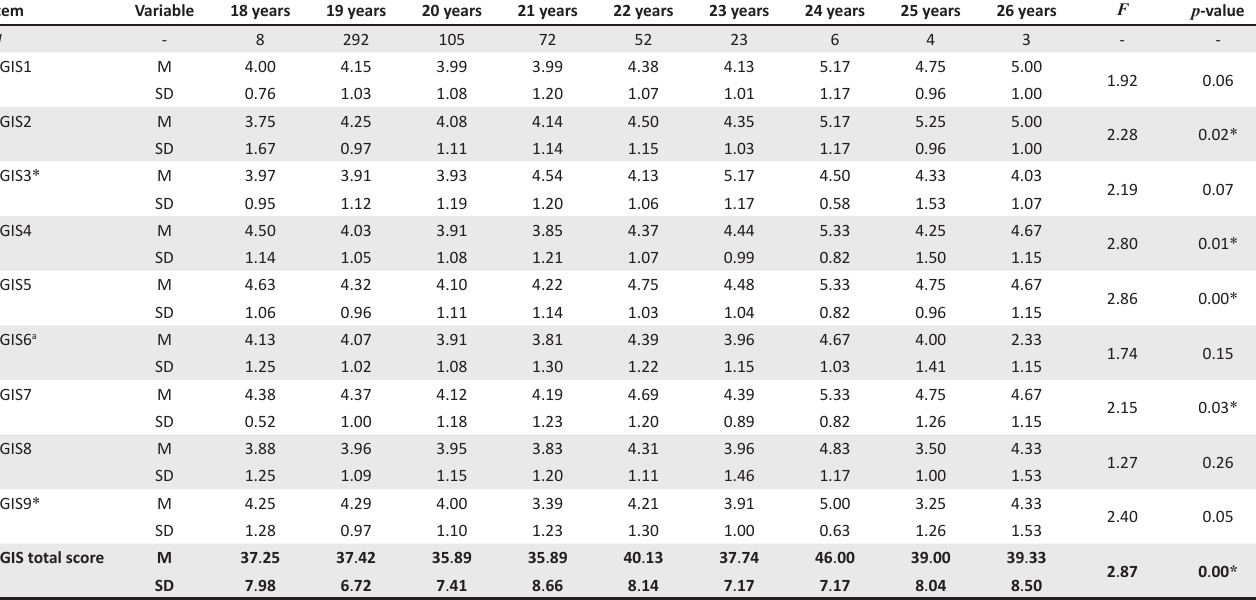
TABLE 3: One-way between-groups ANOVA results for the PGI items and the different age Groups for the I-O Psychology students ( N =